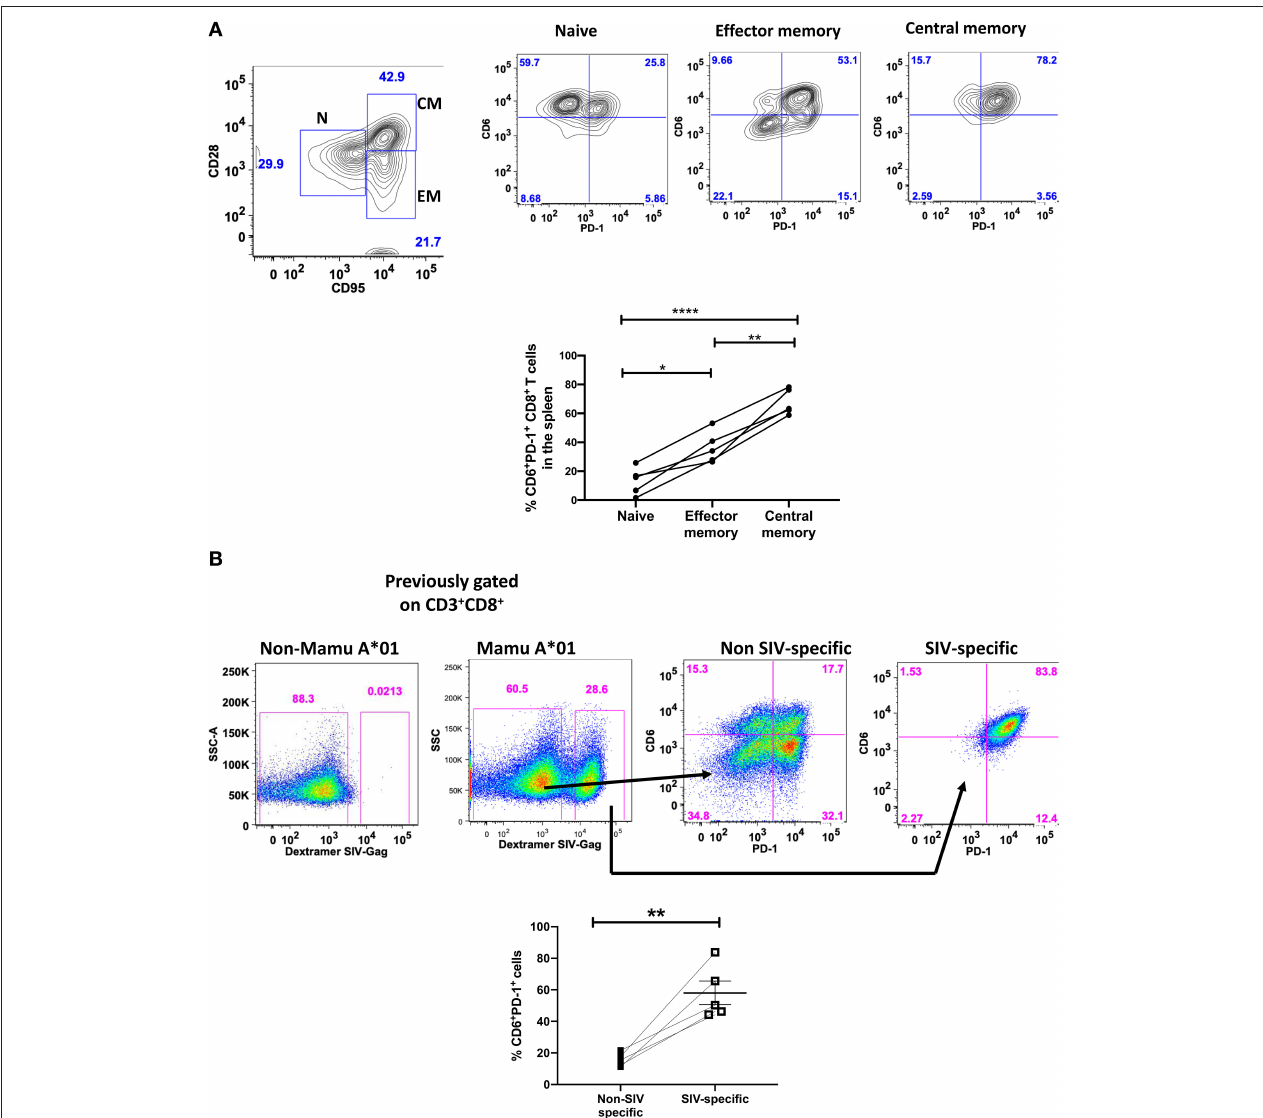
FIGURE 3 | Co-expression of CD6 and PD-1 on memory and SIV-specific CD8 + T cells. (A) Flow cytometry gating strategy for CD6 and PD-1 co-expression on different splenic CD8 + T cell memory subsets. The frequency of CD6 and PD-1 co-expression on naïve, effector and central memory CD8 + T cells. Data are from 5 macaques. (B) Representative staining of CD6 and PD-1 co-expression on CM9-negative and CM9-specific splenic CD8 + T cells. Data are representative of 5 macaques. Shown at the bottom are the frequencies of CD6 and PD-1 co-expression within non-SIV specific and SIV-specific CD3 + CD8 + splenic T cells. SIV-specific are defined as CD3 + CD8 + CM9 + , whereas non-SIV specific are defined as CD3 + CD8 + CM9 − . Data are shown as means ± SEM. For statistical analysis, Mann-Whitney tests were performed. * p < 0.05, ** p < 0.01, **** p < 0.0001.